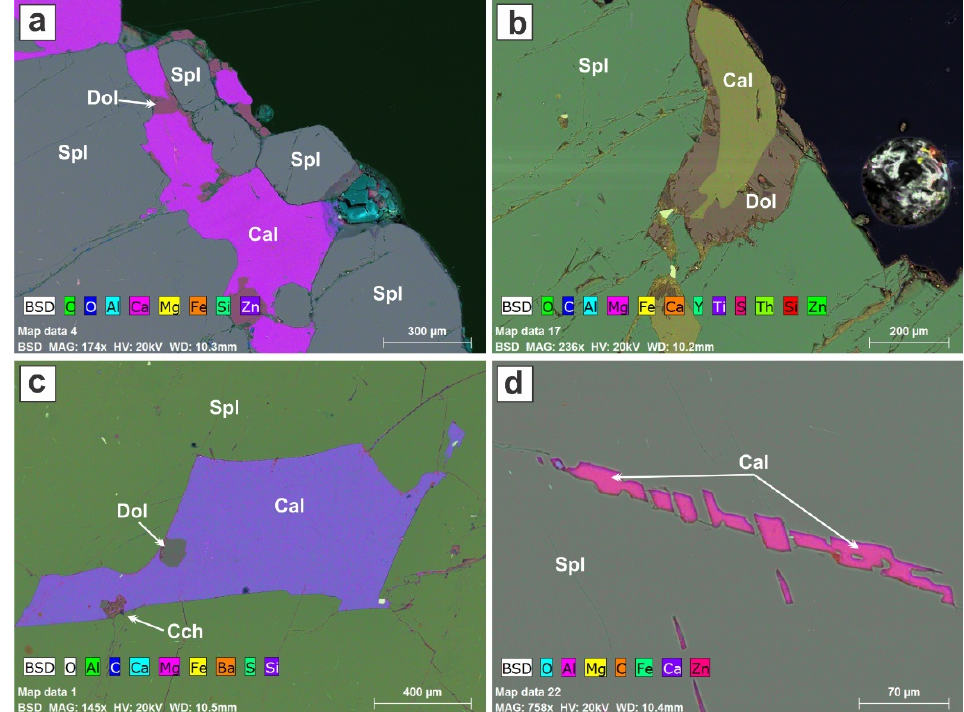
Figure 8. False-color EDS element-distribution maps of the spinel crystal. ( a , b ) Calcite and dolomite mineralization at the periphery of the spinel crystal. ( c ) Large calcite inclusion in the center of the spinel crystal (Figure S3). ( d ) Unusual string-like arrangement of calcite inclusions close to the periphery of the spinel crystal.